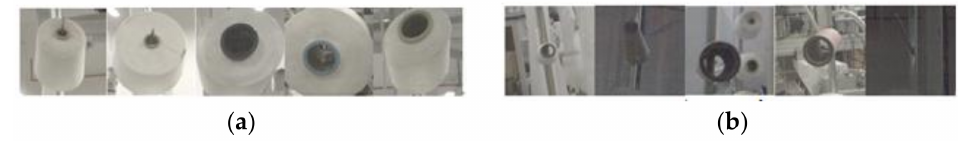
Figure 8. ( a ) Positive samples. ( b ) Negative